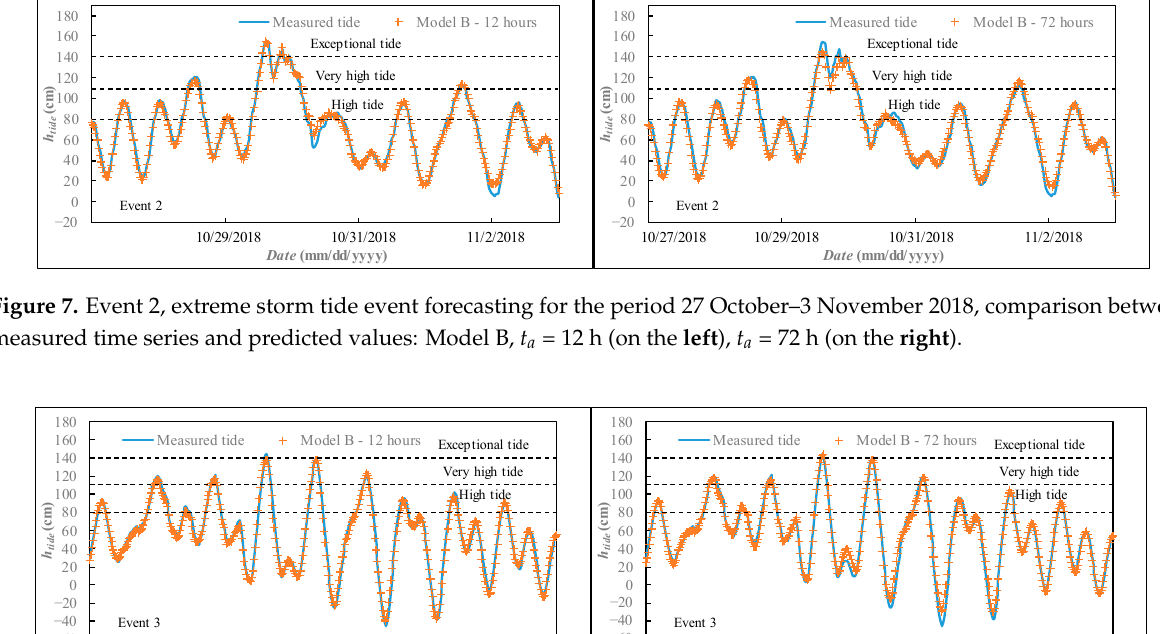
ured time series and predicted values: Model B, t a = 12 h (on the left ), t a = 72 h (on the right ).